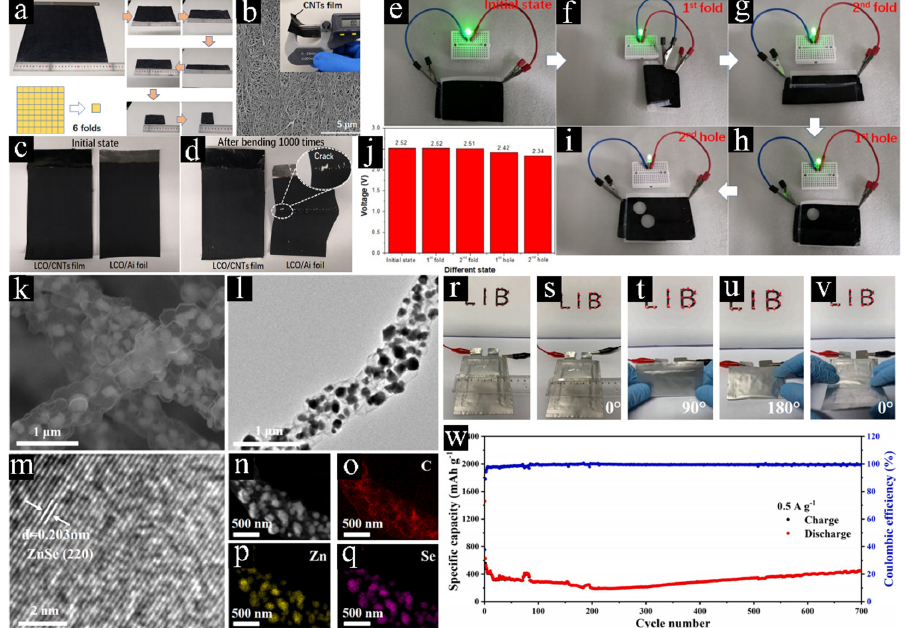
Figure 7. ( a ) Folding process and ( b ) SEM image of the CNT film. Images of LCO/CNT film and LCO/Ai foil ( c ) before and ( d ) after bending 1000 cycles. Flexible test of the battery: ( e ) Initial state. ( f ) After 1st fold. ( g ) After 2nd fold. ( h ) After 1st punch. ( i ) After 2nd punch. ( j ) Voltages under different statuses. ( a – j ) Reprinted with permission from [77]. Copyright Elsevier Publisher, 2022. ( k ) SEM, ( l ) TEM, ( m ) HRTEM and ( n – q ) Annular dark-filed TEM image of ZnSe@CNFs-2.5. Qualitative test of the pouch cell by power LEDs under various deformations: ( r ) Pristine, ( s ) 0°, ( t ) 90°, ( u ) 180°, ( v ) back to 0°. ( w ) Cycling stability of the cell. ( k – w ) Reprinted with permission from [83]. Copyright